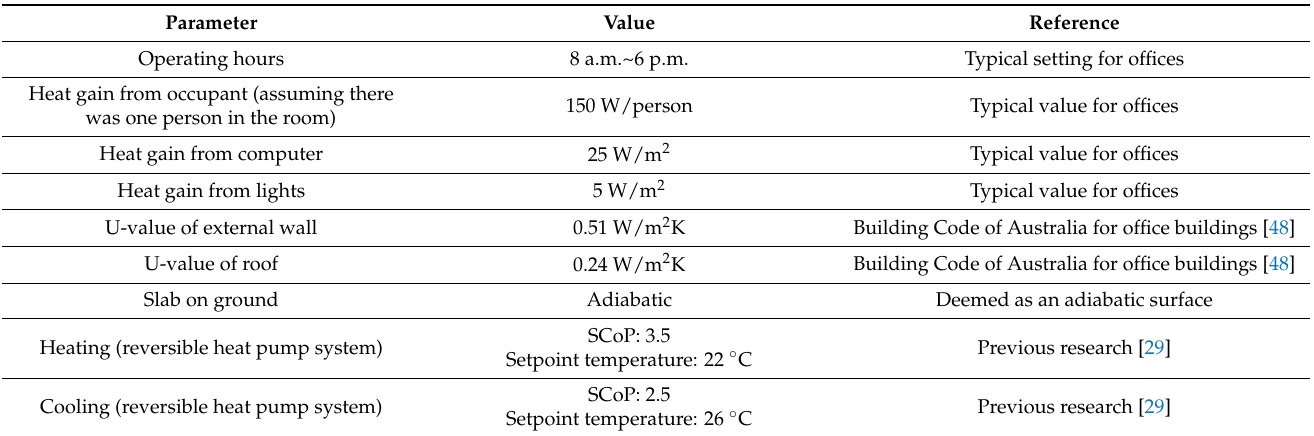
Table 5. Design parameters with constant values.